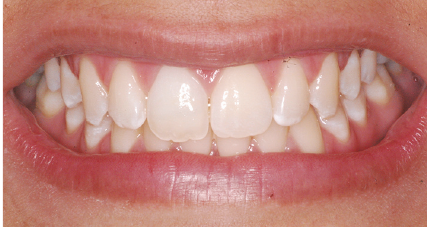
Figure 10: Final clinical